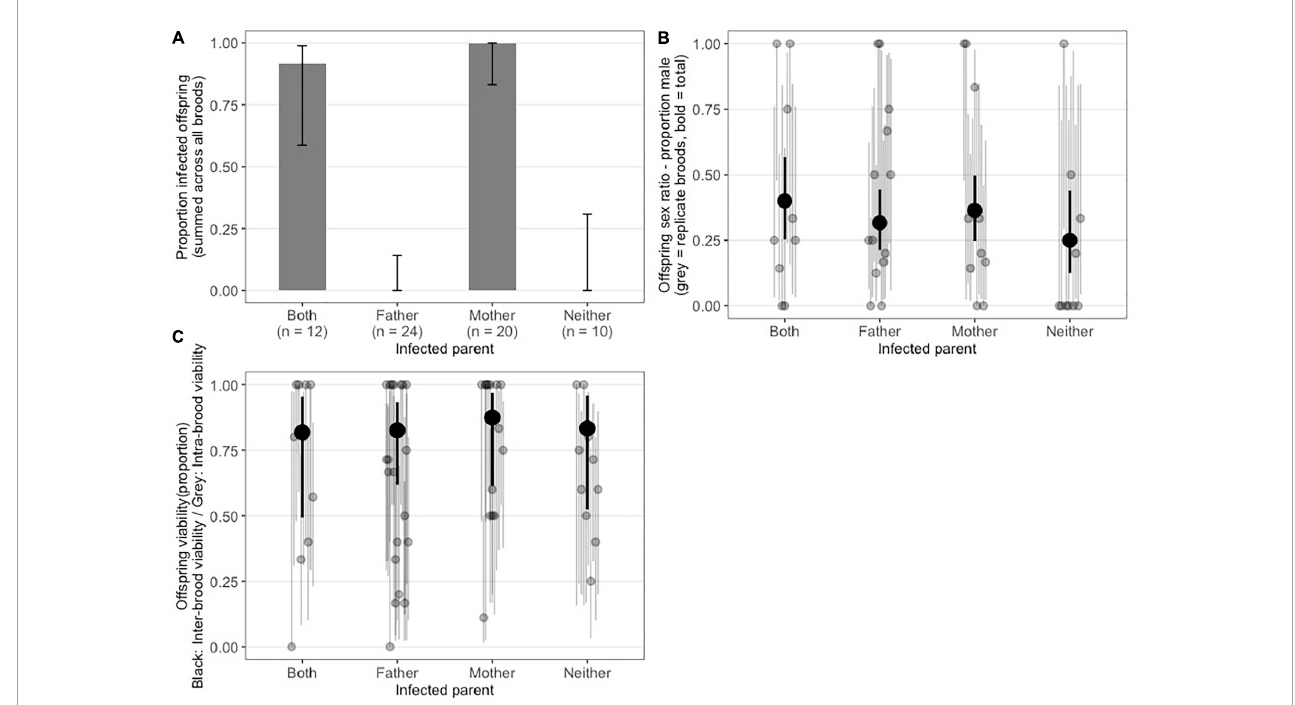
FIGURE2 (A) Proportion of P. vindemmiae progeny positive for A. nasoniae a Pv partitioned by parental infection status: Both mother and father infected, father only, mother only, and neither. Results are given as the mean of replicate crosses, with error bars representing 95% binomial confidence intervals. (B) Offspring sex ratio (proportion male) from crosses with different infection status. Gray dots indicate individual families, Black dot represents mean across replicate families. (C) Offspring viability (proportion of pupae successfully parasitized with emerging wasp). Gray dots indicate individual families, Black dot represents mean across replicate families.